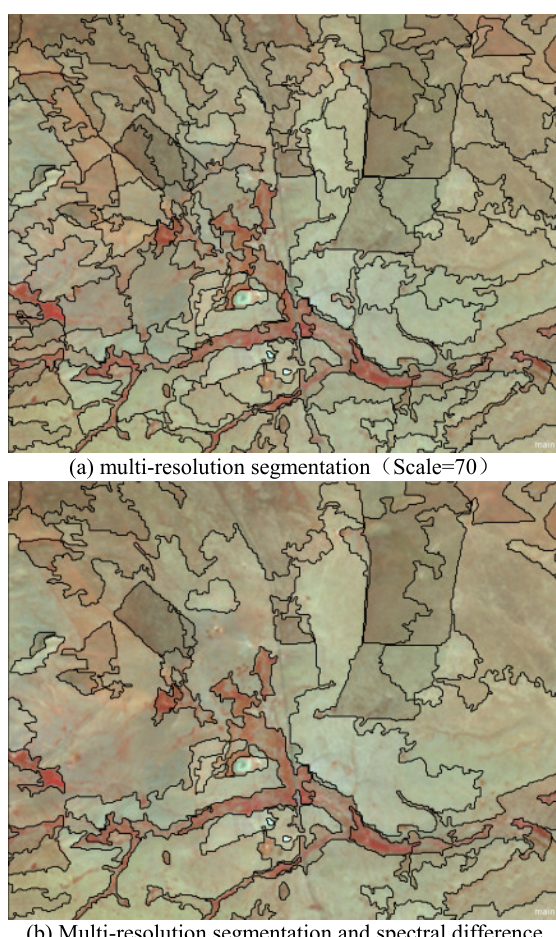
Figure 2 the contrast of segmentation